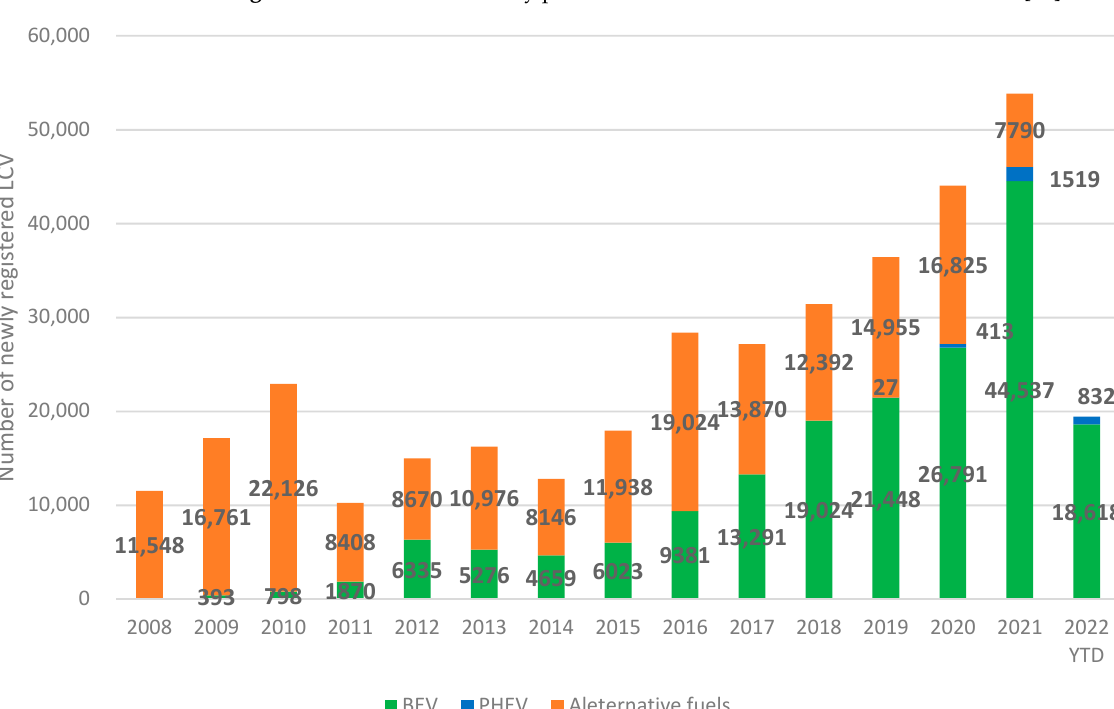
Figure 4. Newly registered LCVs—BEVs, PHEVs and alternative fuels. Source: EAFO [89].